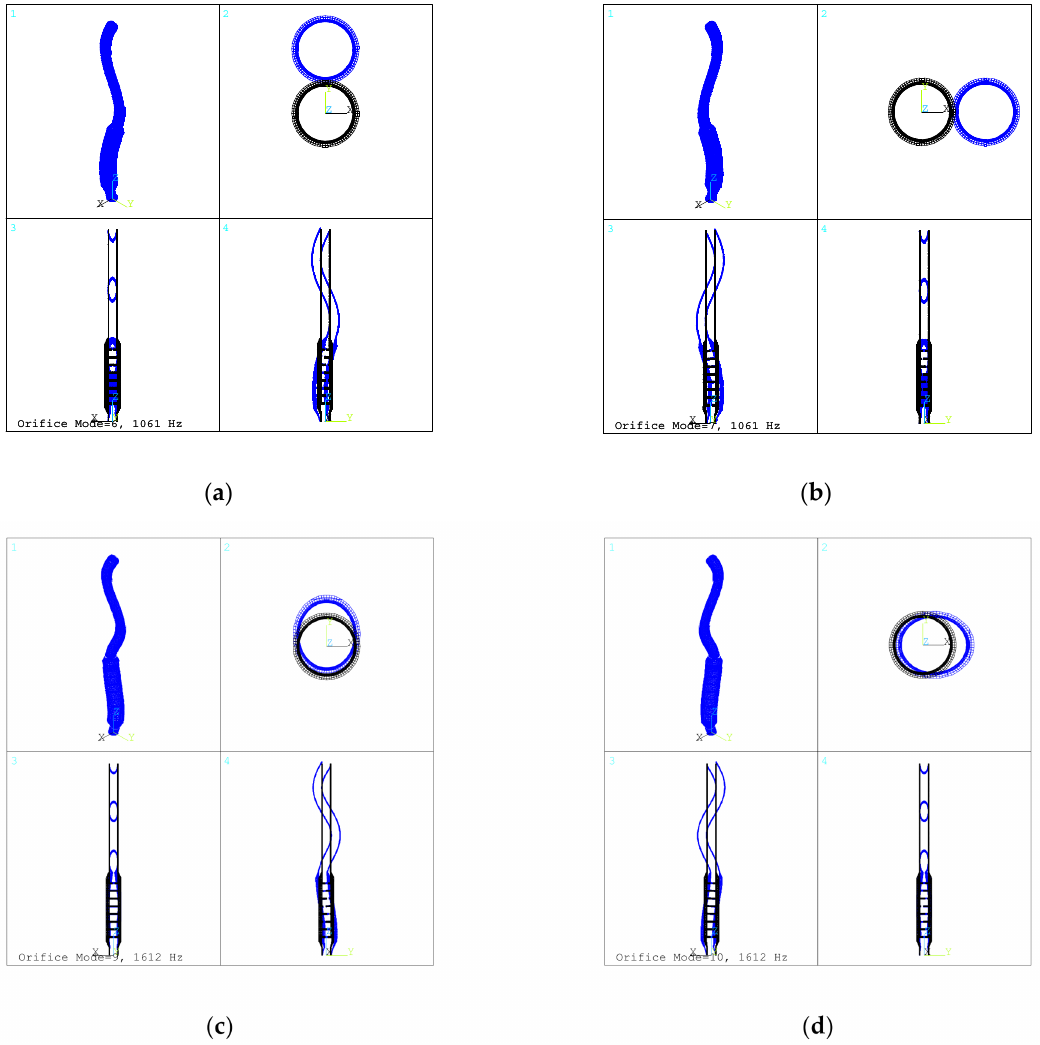
Figure 18. Mode shapes of the multi-stage orifice and the connecting pipe: ( a ) d 8 /d = 0.84; ( b ) d 8 /d = 1.0 (original case); ( c ) d 8 /d = 1.24; and ( d ) d 8 /d = 1.49.